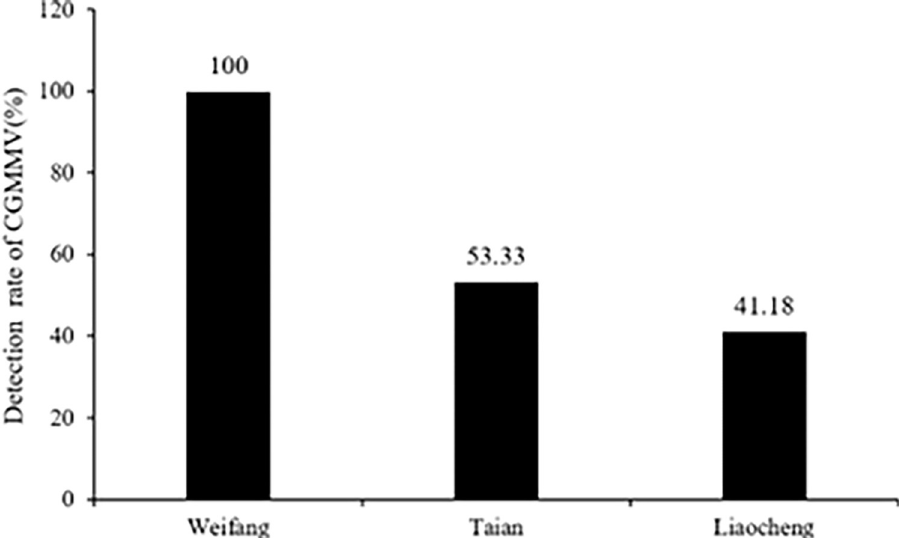
Fig 3. Detection of CGMMV in different PVGAs in